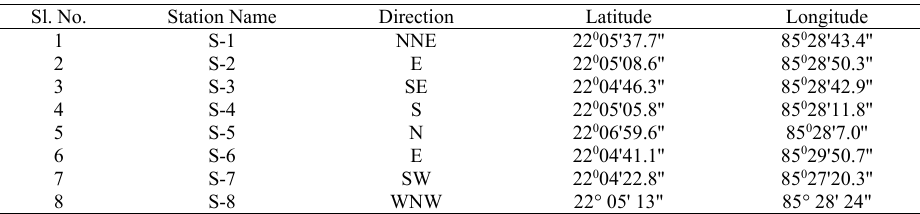
Table 1. The sampling station details